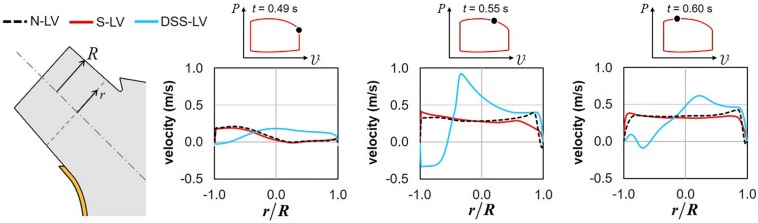
Snapshots of the velocity profiles captured in the N-LV, S-LV, and DSS-LV models at the base of the LVOT during early systole (0.49 s), acceleration phase (0.55 s), and at peak systole (0.60 s) (r: radial position; R: LVOT radius).